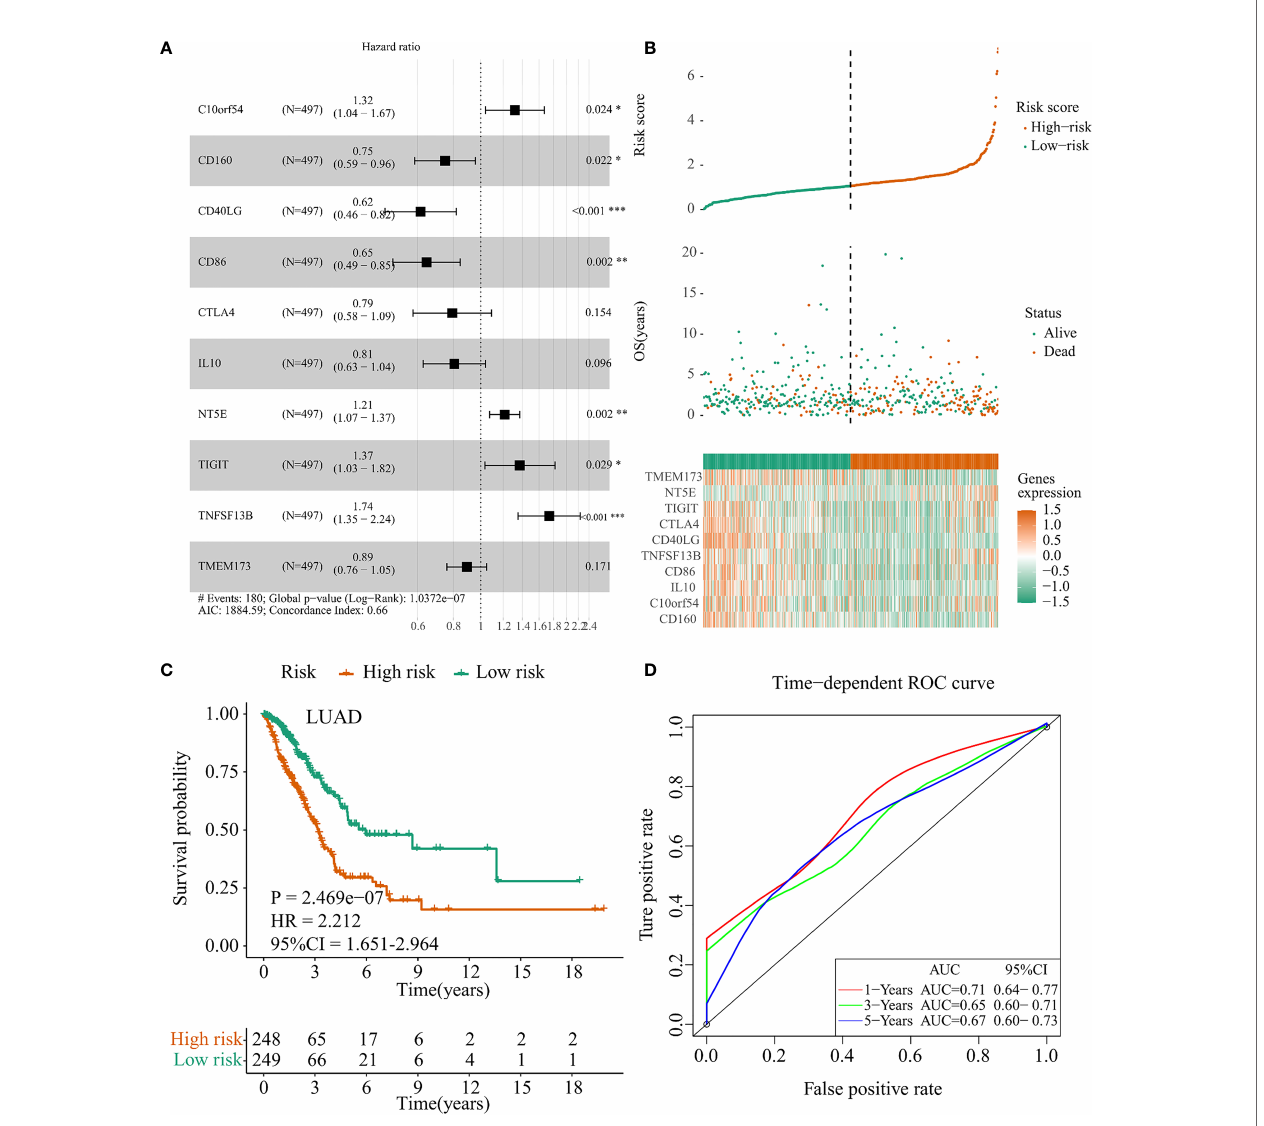
FIGURE 4 | Construction of the IFI44L -related immunomodulators signature in TCGA-LUAD cohort. (A) Development of the prognostic signature based on 44 IFI44L - associated immunomodulators through multivariate stepwise Cox analysis, and the results are shown in a forest plot. (B) Distribution of the risk score, survival status, and expression pro fi ling of immunomodulators integrated in this signature. (C) The cohort was separated by median cutoff value of risk score, and the difference in survival was performed using a Kaplan – Meier plot. (D) Time-dependent ROC curves at 1 year, 3 years, and 5 years for evaluating the speci fi city and sensitivity of this risk signature. TCGA, The Cancer Genome Atlas; LUAD, lung adenocarcinoma; ROC, receiver operating characteristic. * p < 0.05, ** p < 0.01, *** p <